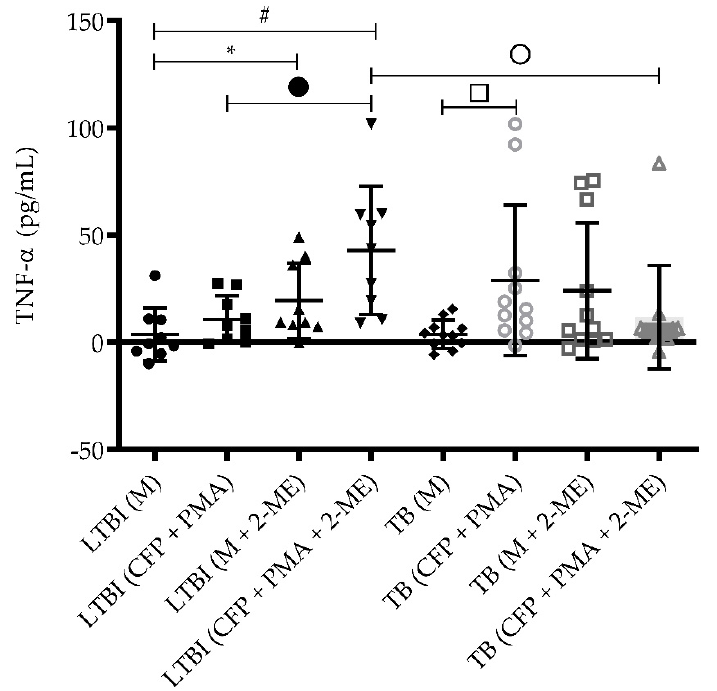
Figure 4. TNF- α levels in culture supernatants of PBMCs isolated from healthy controls, individuals with LTBI, and patients with active TB. TNF- α levels in PBMC culture supernatants was determined using sandwich ELISA to determine cytokine levels in individuals with LTBI and patients with TB. PBMCs were treated with 2-ME for HIF-1 α blockade and stimulated with CFP + PMA. * p = 0.0436 for LTBI (medium + 2-ME) versus LTBI (medium alone); # p = 0.0023 for LTBI (CFP + PMA + 2-ME) versus LTBI (medium alone); • p = 0.0081 for LTBI (CFP + PMA + 2-ME) versus LTBI (CFP + PMA); □ p = 0.0307 for TB (CFP + PMA) versus TB (medium alone); ◦ p = 0.0190 for TB (CFP + PMA + 2-ME) versus LTBI (CFP + PMA + 2-ME). Data are presented as the mean ± (SD) and represent one of three independent experiments. Statistical analysis was performed using ANOVA and post hoc t-test, with a significance of p < 0.05. Abbreviations: pNF- κ B, phosphorylated NF- κ B; M, medium; CFP, culture filtrate protein; PMA, phorbol 12-myristate 13-acetate; 2-ME, 2-methoxyestradiol.